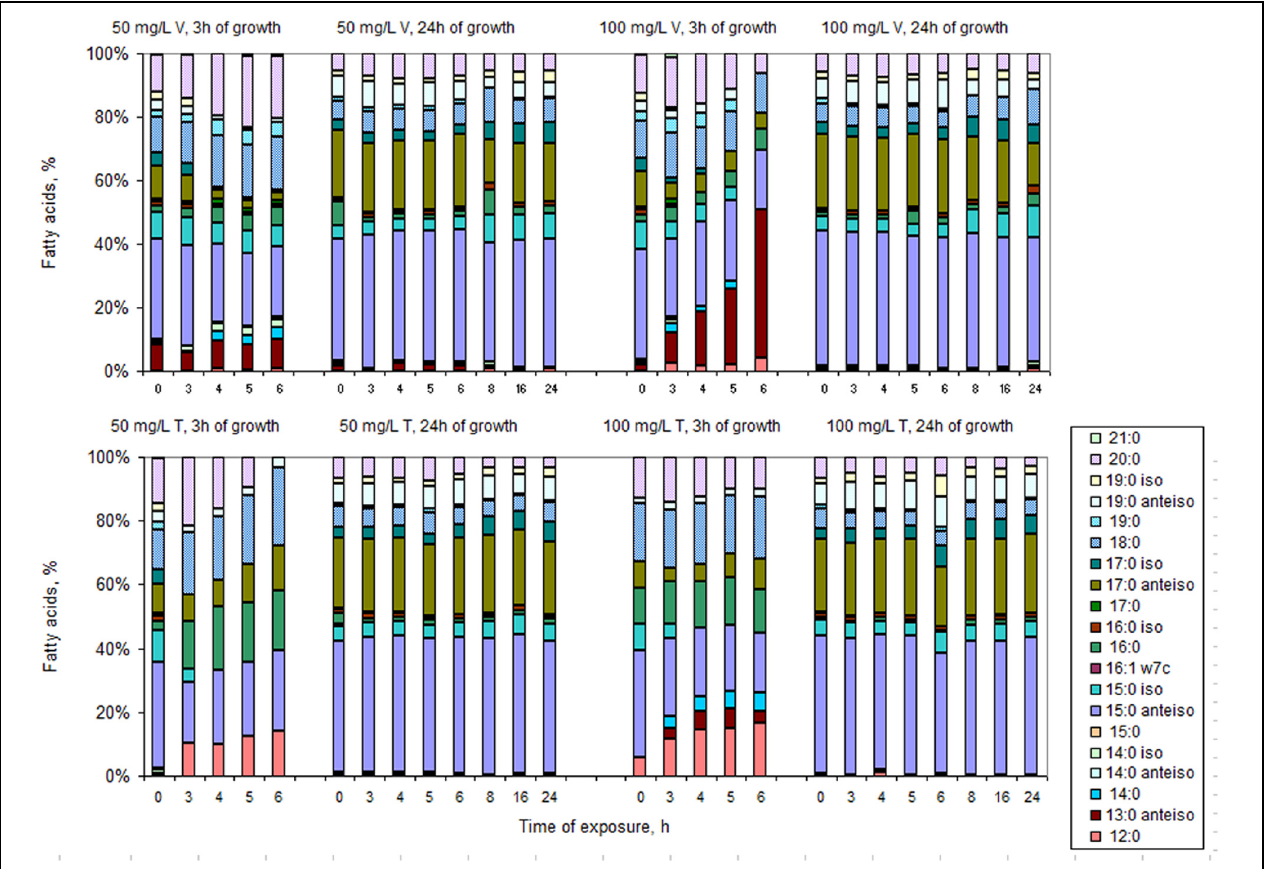
FIGURE 4 | Fatty acid composition of cells growing for 3 and 24 h in drug-free MHB after exposure to 50 and 100 mg/L vancomycin (V) and teicoplanin (T) for 3, 4, 5 and 6, 8, 16, and 24